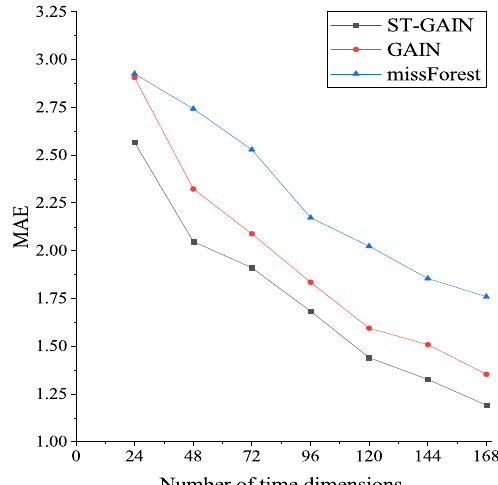
Figure 13. MAE for different time dimensions.